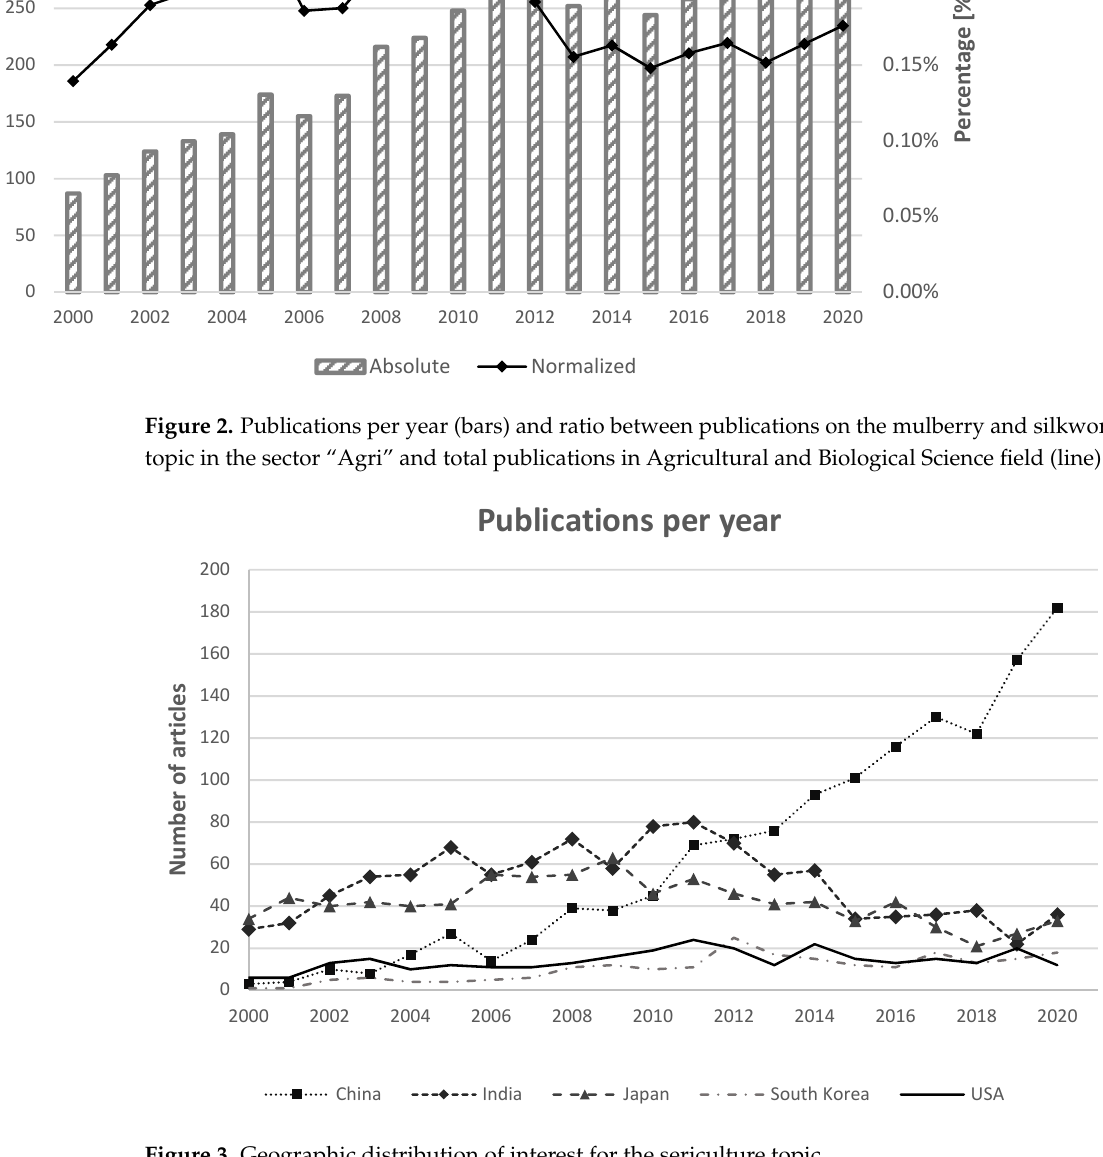
Figure 3. Geographic distribution of interest for the sericulture topic.